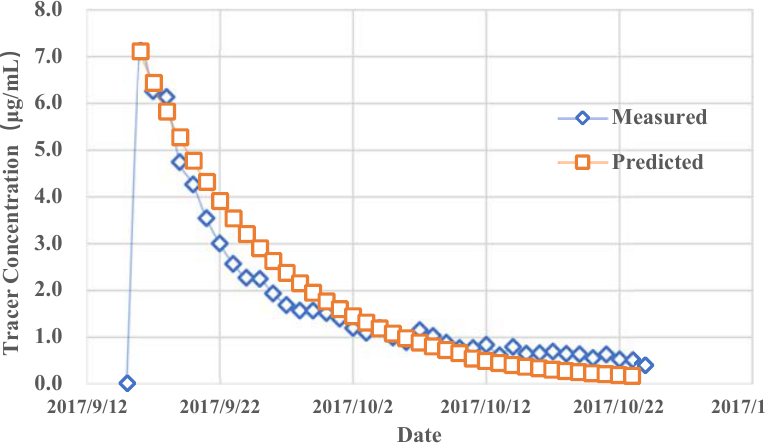
Figure 8. Comparison between measure tracer breakthrough curve and predicted curve.